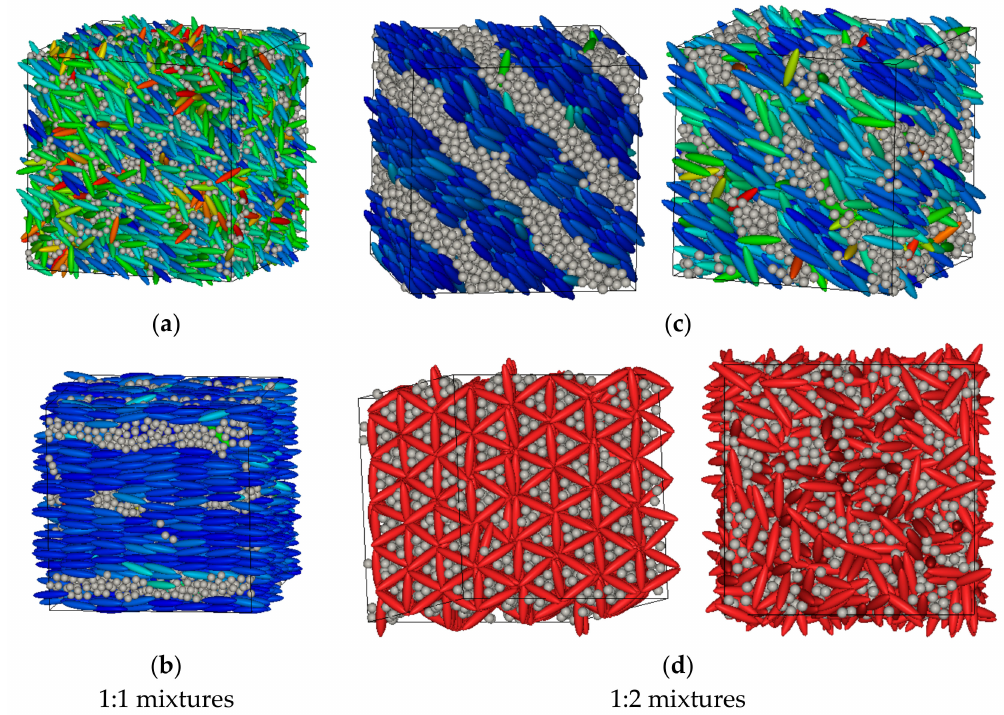
Figure 7. ( a ) 1:1 mixture: ionic nematic phase: q * = 0.50/ − 0.50, T * = 4.00; ( b ) 1:1 mixture: microphase segregated ionic smectic phase: q * = 0.50, T * = 1.00. ( c ) 1:2 mixture: ionic nematic phase: q * = 0.50/ − 0.25, T * = 1.00 (left snapshot) and T * = 2.00 (right snapshot); ( d ) 1:2 mixture: microphase segregation GB and